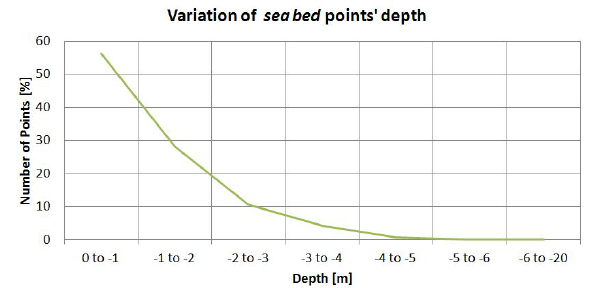
Figure 11: Gaps in data sets of HawkEye (blue) and Riegl (yel-